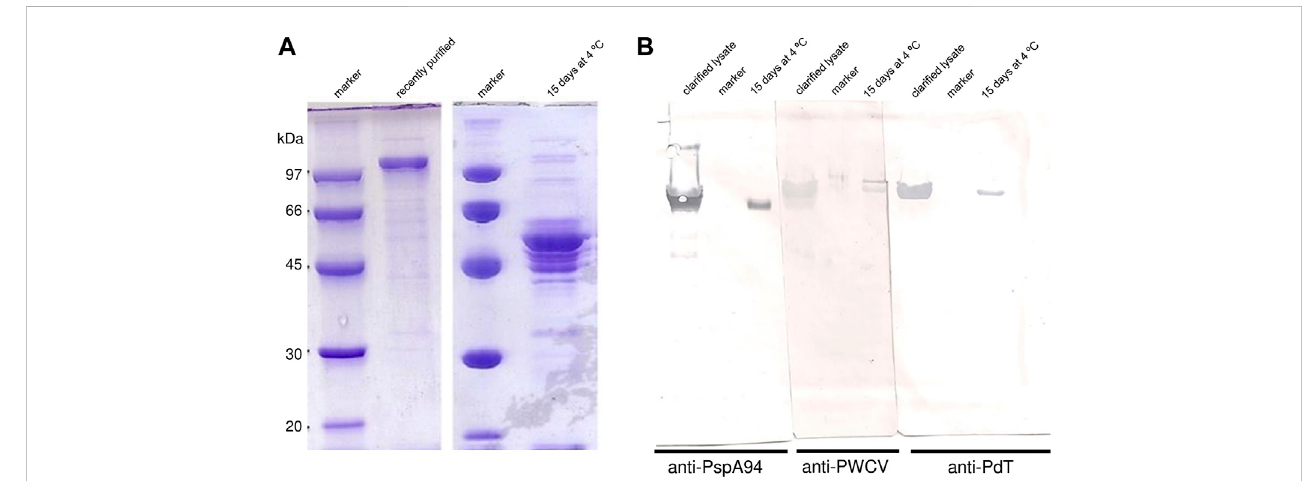
FIGURE 1 Degradation of PspA-PdT observed during puri fi cation trial. (A) SDS-PAGE 10% assessing PspA-PdT purity and stability. PspA-PdT sample after puri fi cationbyhydrophobicinteraction,0and15 daysafterstorageat4 ° Cwereloaded. (B) WesternblotassessingPspA-PdTstabilityusingdifferentantibodies for detection;clari fi edlysate, marker and 15-day puri fi edPspA-PdT stored at 4 ° C wereloaded intriplicates, transferred, themembranewas split in three parts and incubated with different antibodies: anti-PspA94, anti-PWCV (pneumococcal whole cell vaccine) and anti-PdT. Detection was achieved with 3,3 ′ -